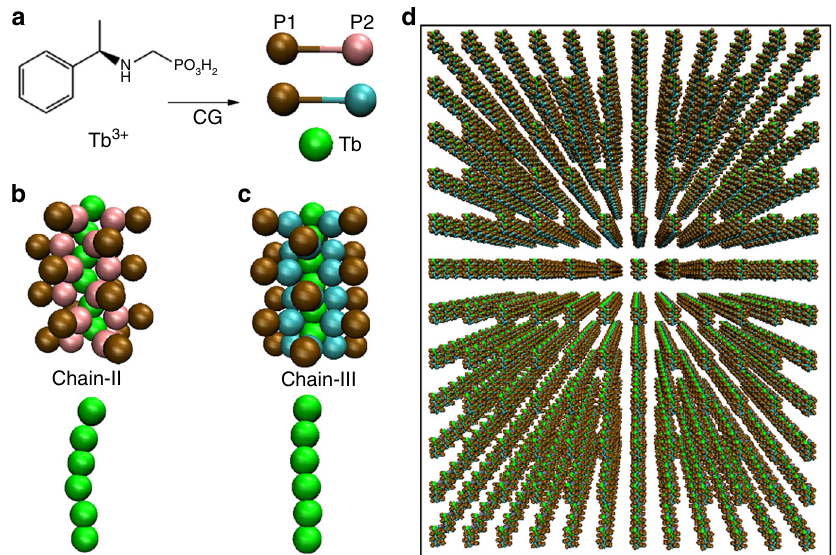
Fig. 8 The setup of Brownian dynamics simulations. a Schematic illustration of the CG models for R -pempH − ( R -pempH 2 ) molecule and Tb 3+ . Snapshots of CG model for chain-II b and chain-III c with six Tb 3+ ions and eighteen R -pempH − ( R -pempH 2 ) molecules. To better differentiate the chain-II and chain-III, the bead that can interact with Tb 3+ is used as pink and lime one, respectively. d The initial conformation of the self-assembly system, where the chains-II (and/or chains-III) are distributed uniformly in the simulation